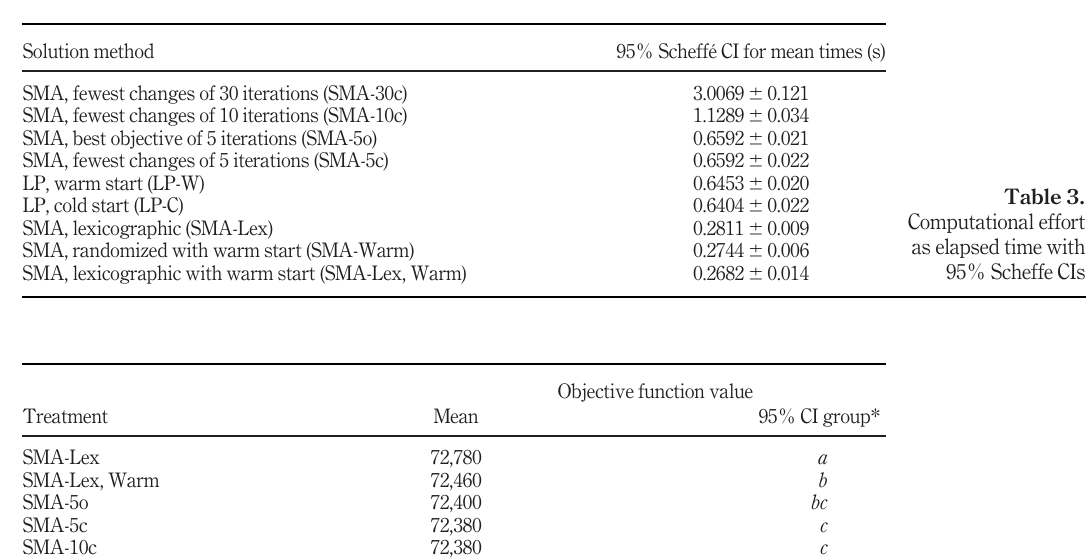
Table 4. Solution quality